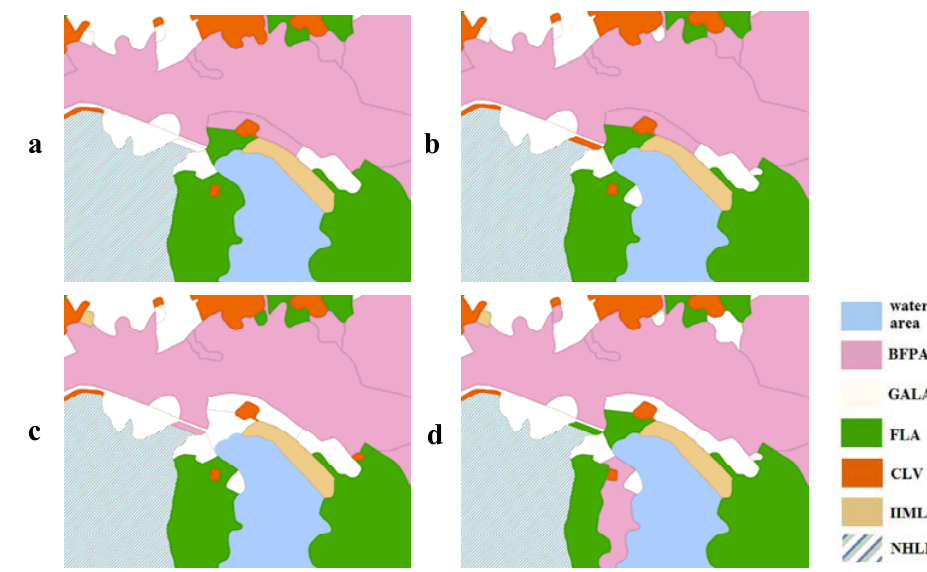
in improving the spatial harmony in different weighted Figure 9. The effects of w 3